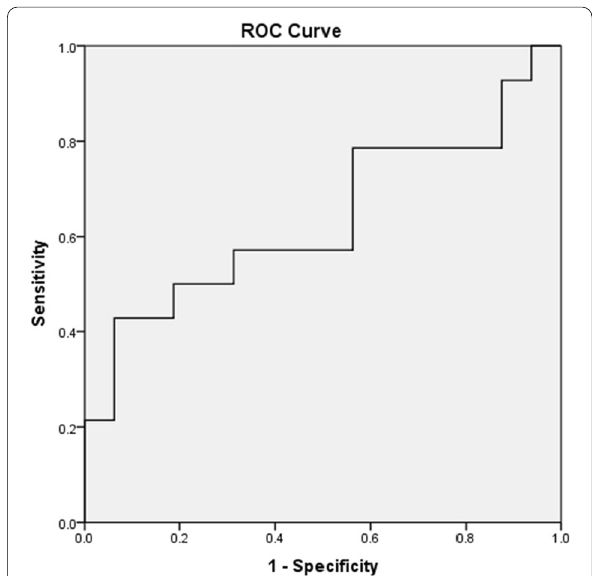
Fig. 4 ROC curve for TNF‑α to detect cognitive impairment in patients with PD using trail making B. At cut‑off point value > 113.65, sensitivity and specificity of TNF‑α were 57.1, 56.2%, respectively (AUC